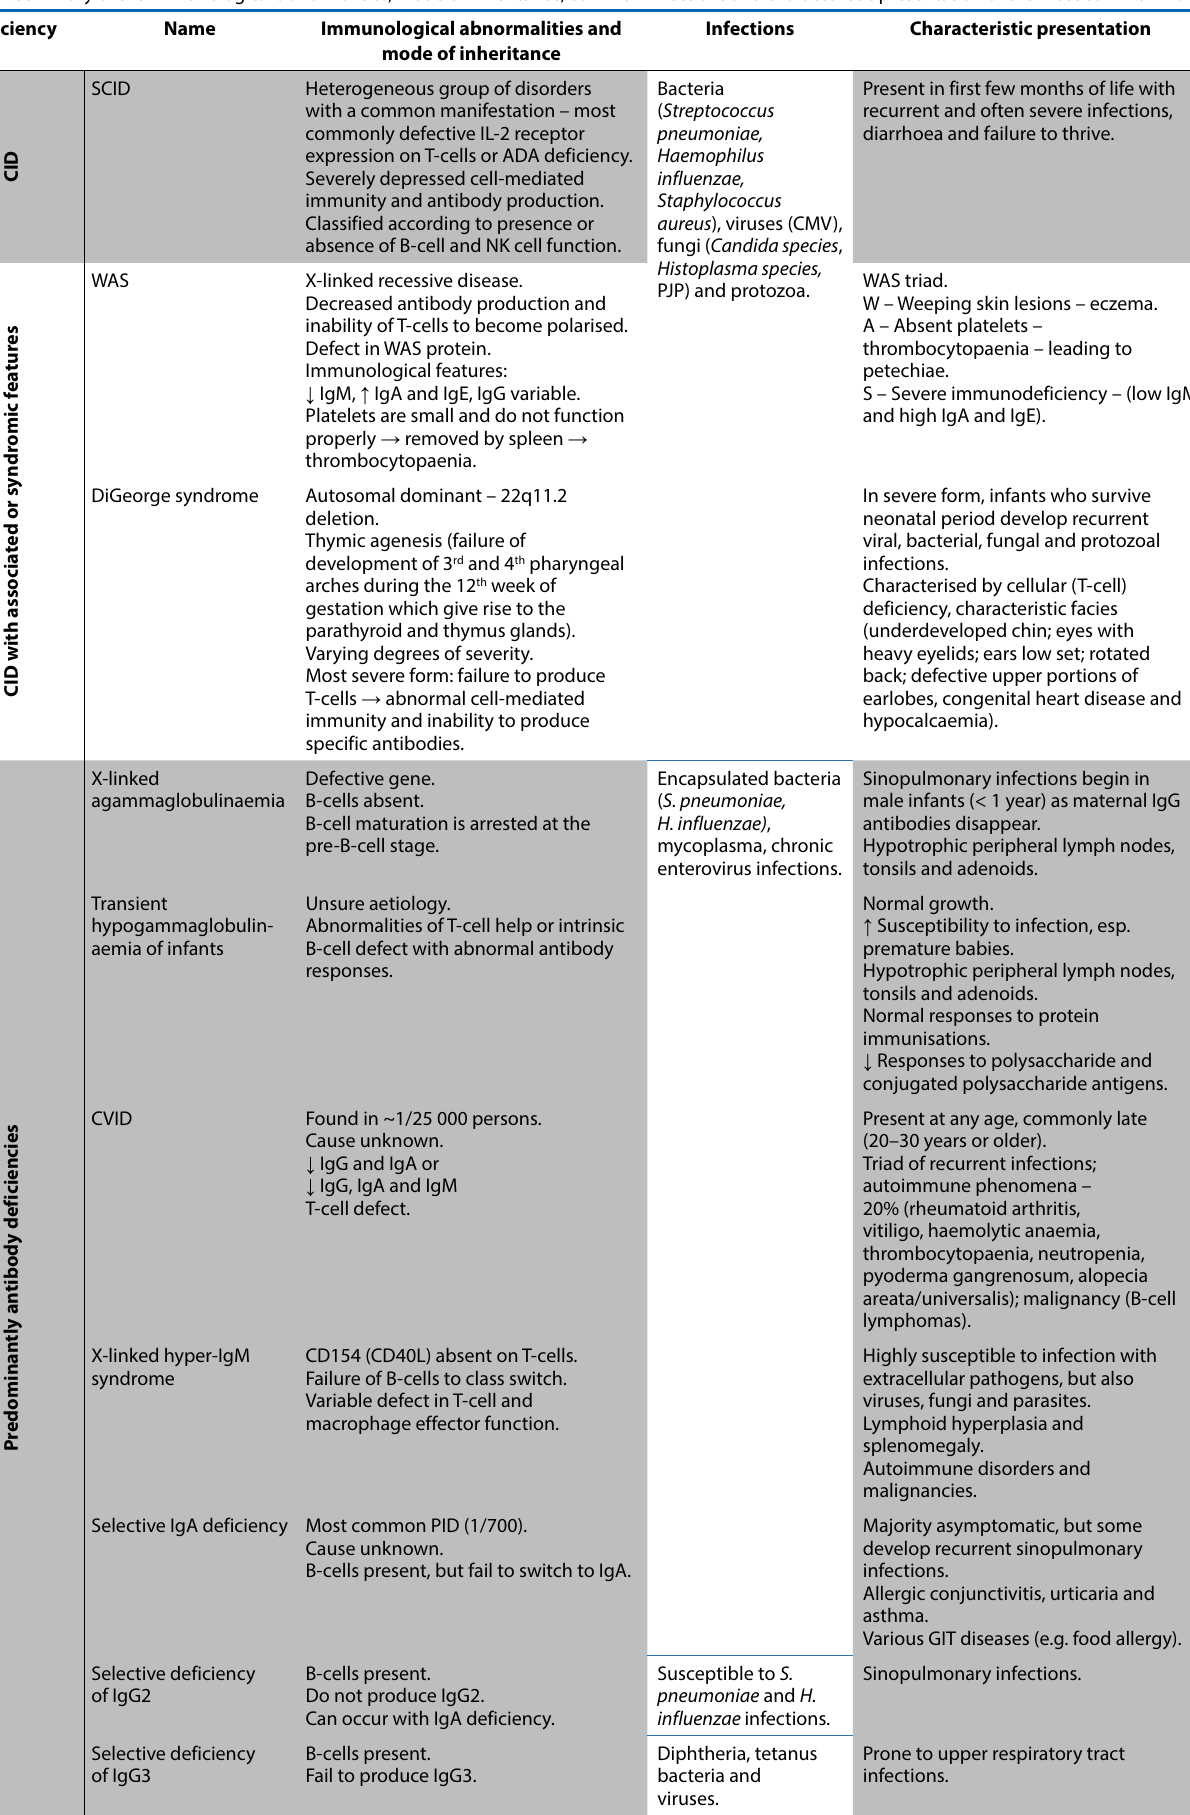
Table II. Summary of the immunological abnormalities, mode of inheritance, common infections and characteristic presentation of the most common PIDs